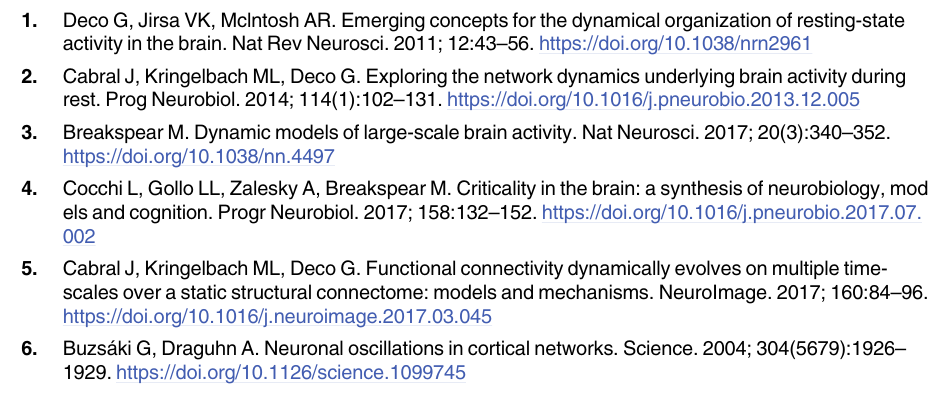
in condition d = 1 for all the mod- 0